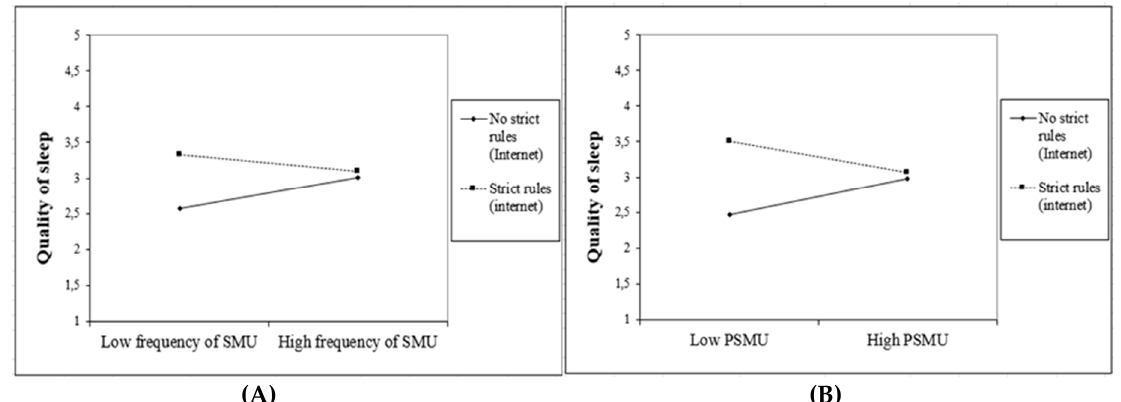
Figure 2. Moderation of the effect of frequency of social media use (SMU) and problematic social media use (PSMU) on bedtime by parental rules about using the Internet in the hour before going to sleep ( A ) and about taking the smartphone to the bedroom when going to sleep ( B